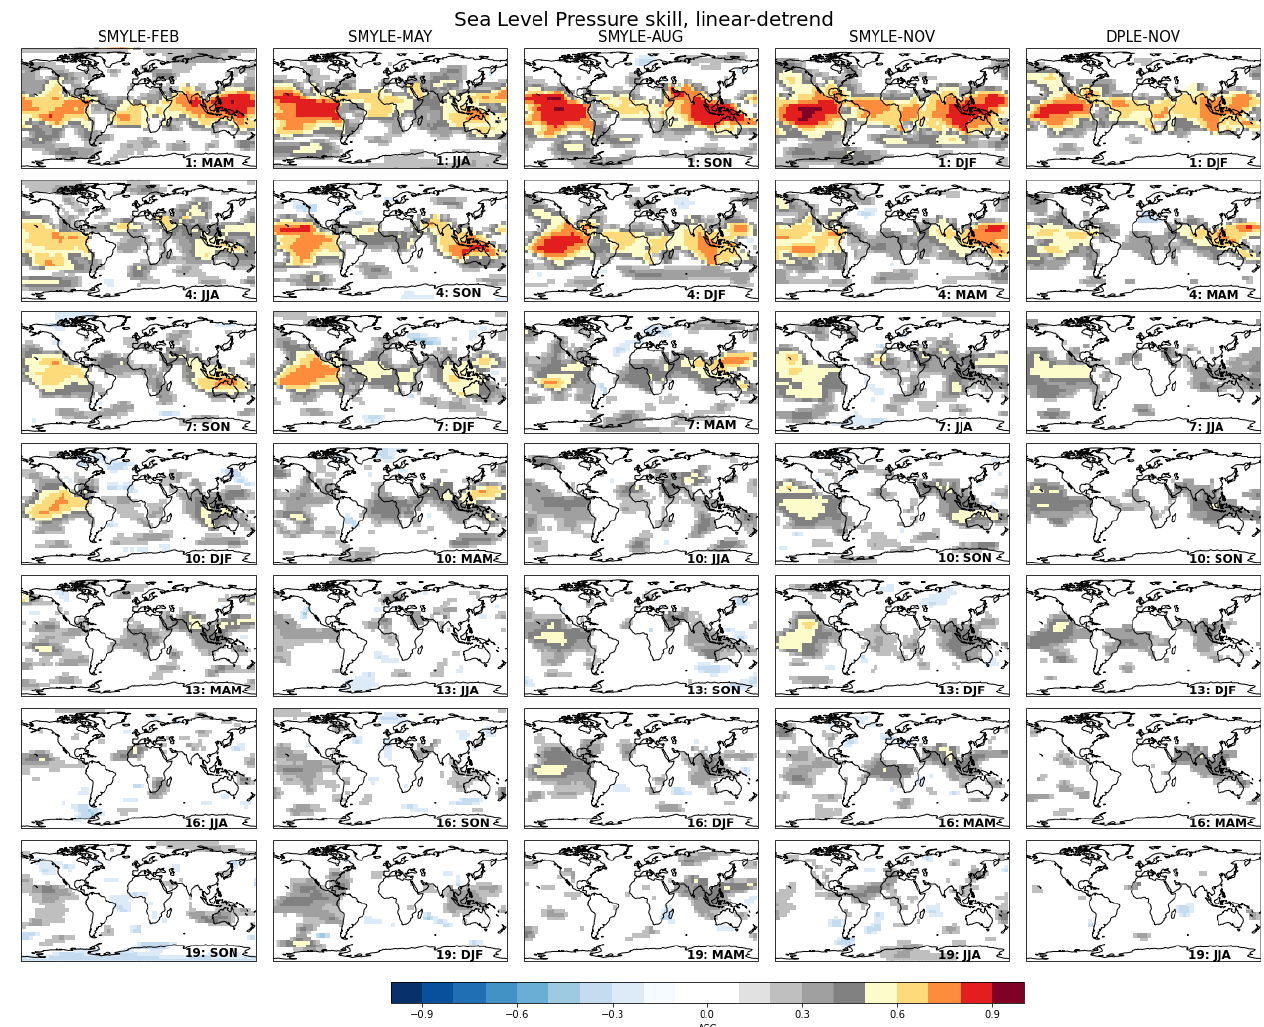
Figure 6. Anomaly correlation coefficient (ACC) for sea level pressure after removing a linear trend. Columns correspond to different 20- member hindcast sets from SMYLE, with the far-right column showing 20-member DPLE results. Rows correspond to forecast season as indicated by labels that give forecast lead time and target season. Correlations are plotted only where significant ( p < 0.1). The verification dataset is ERA5 reanalysis. Figure B5 shows corresponding maps for non-detrended data, and Fig. B6 shows where SMYLE-NOV differs significantly from